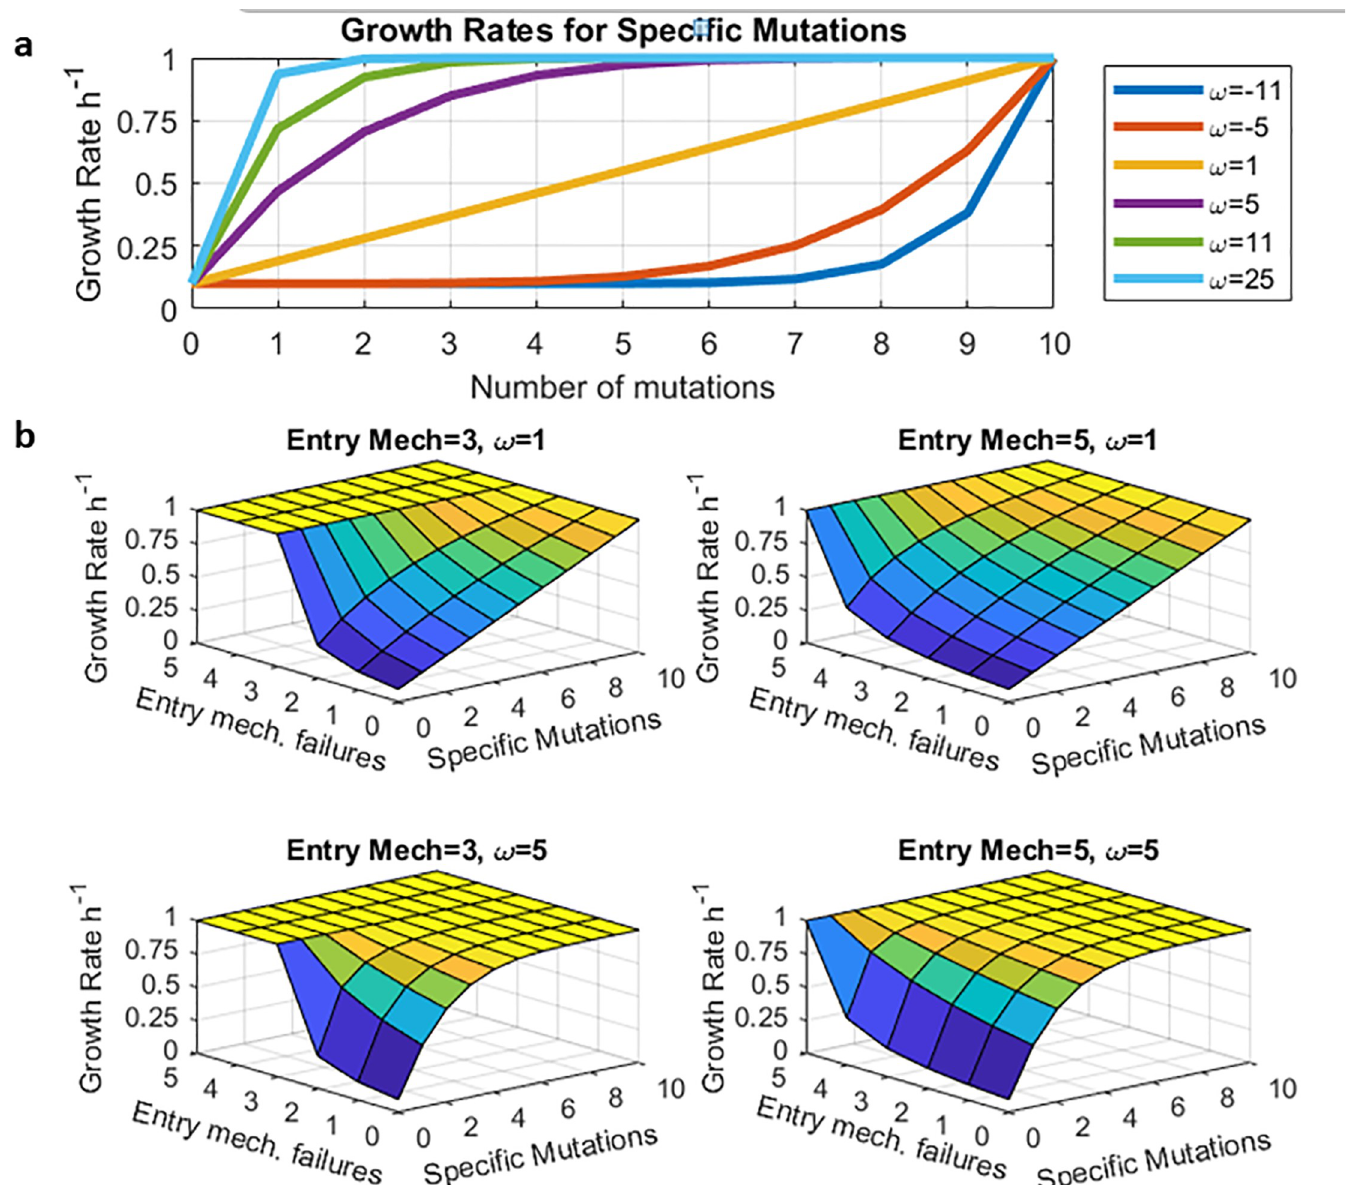
Fig 3. Illustration of fitness landscapes for Different ω : A . Functional dependence growth rate vs number of specific mutations as a function of the parameter ω in (Eqs 4 and 5). The higher the ω the more advantage the specific mutations provide. B . Sample fitness landscapes are made by combining curves from A. and Fig 2A. by (Eq 3). These surfaces define possible mutational pathways of evolutionary escape of the pathogens from the antisense therapy.